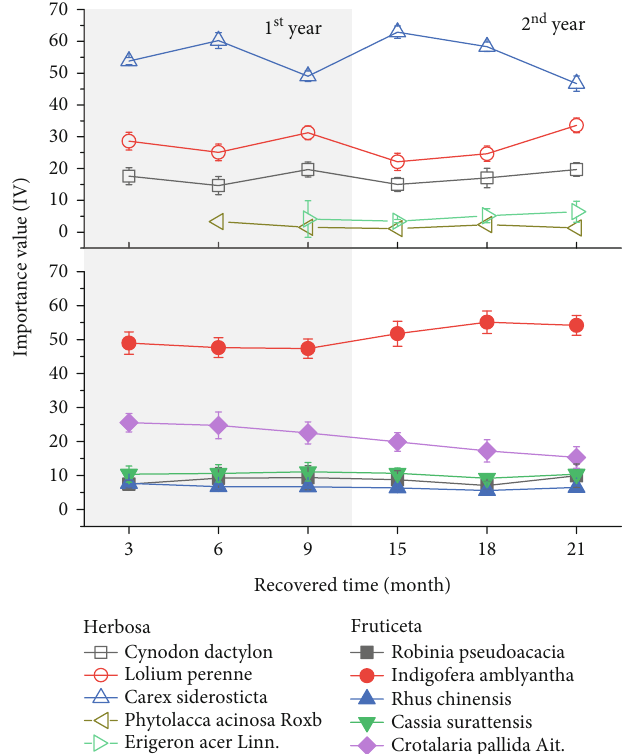
Figure 2: The importance value (IV) of species in herbosa and fruticeta community with the recovered times. The error bar was the standard